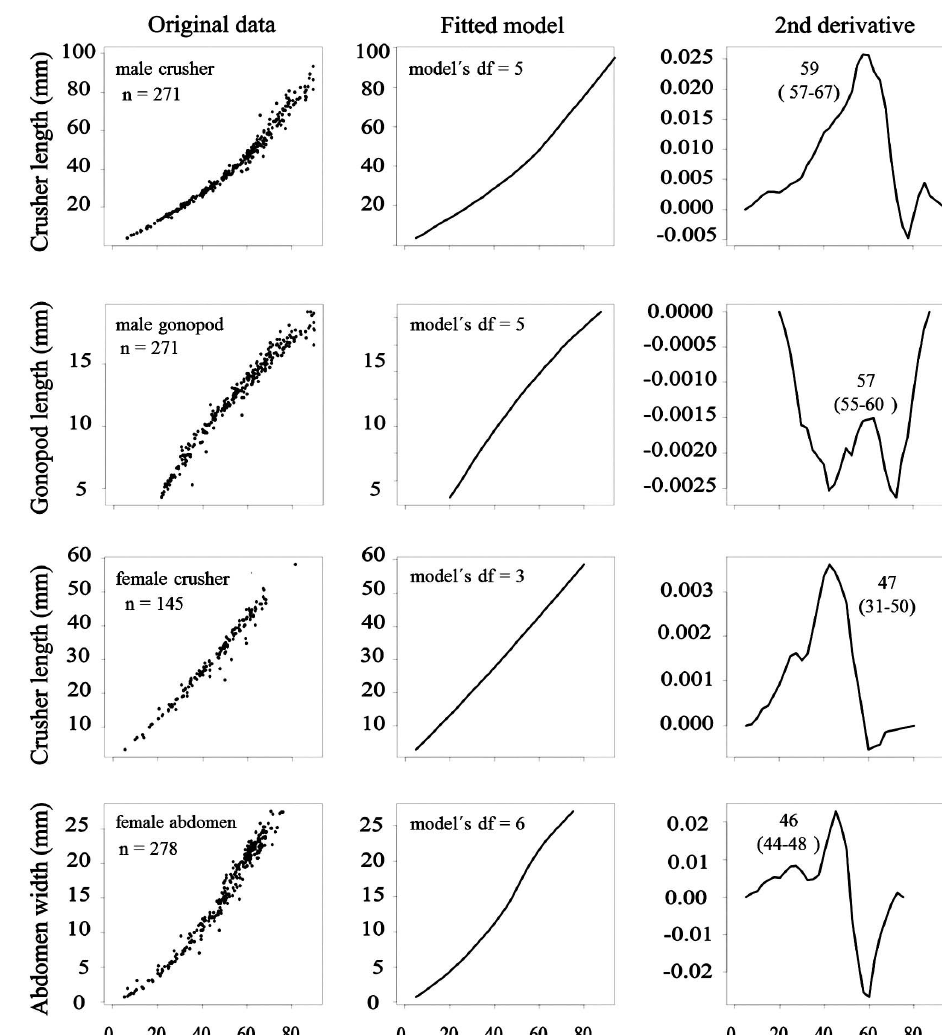
5. – Relative growth and morphometric maturity of Platyxanthus crenulatus . Size at morphometric maturity as determined by the splines method (Watters and Hobday 1998) applied to morphometric data of selected measures of males and females. The most appropriate model was chosen according to the generalized cross-validation criterion (GCV). The peaks in the second derivative of the selected model are marked changes in relative growth that correspond to morphometric maturity.